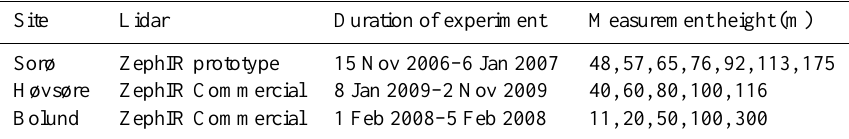
Table 1. Overview of lidar